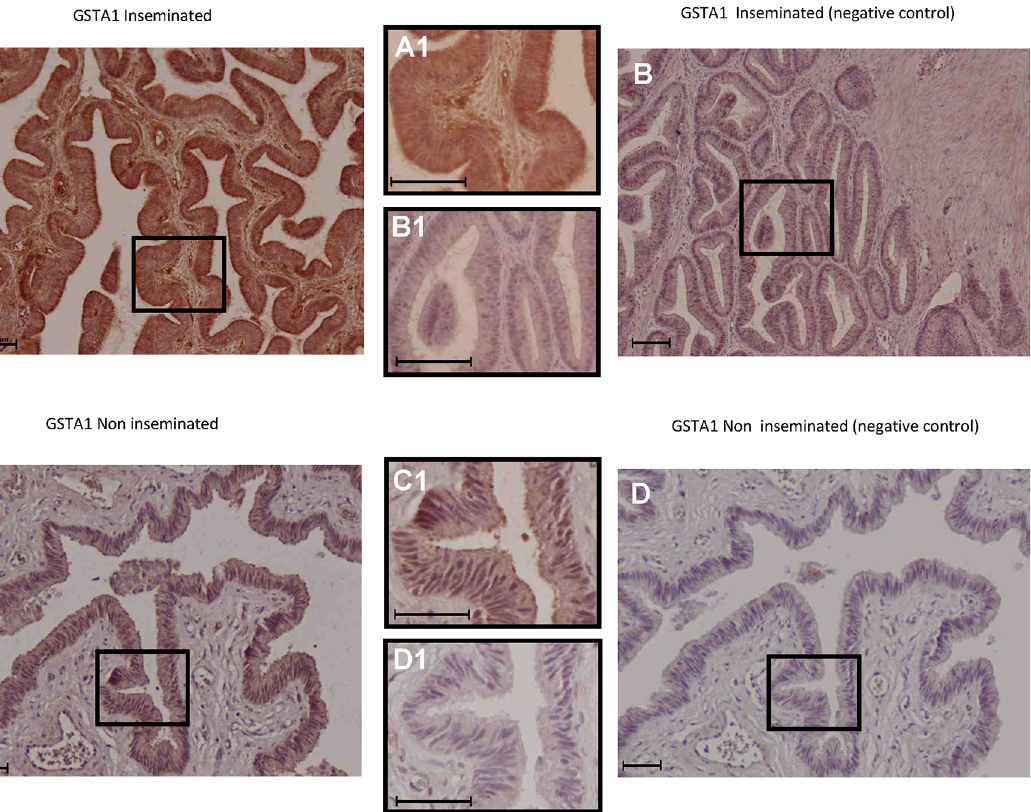
Fig 6. Immunohistochemical localization of GSTA1 in the porcine oviduct. GSTA1 protein expression extended from the epithelial cells to deeper layers of the oviductal wall in the inseminated sows (Fig 6A, magnified in 6A1) compared with the non-inseminated animals, where labelling was mainly observed at the epithelial level (Fig 6C, magnified in 6C1). The corresponding negative controls are shown in Fig 6B, magnified in 6B1 for the inseminated animals and in Fig 6D, magnified in 6D1, for the non-inseminated sow. In all figures, scale bars correspond to 100 μ